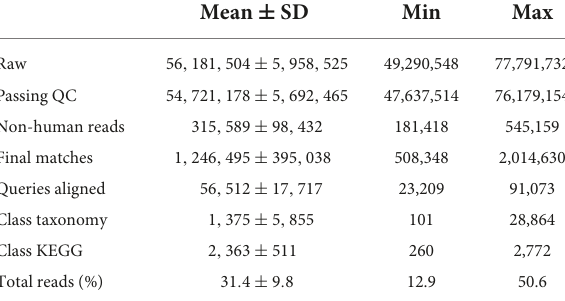
TABLE 2 Sequencing reads.